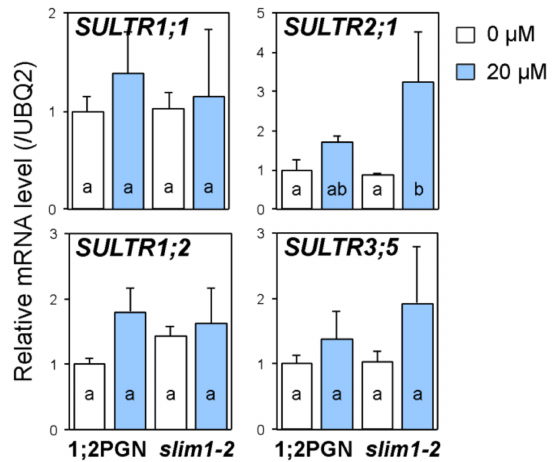
Figure 3. E ff ects of Cd treatment on transcript levels of SULTR s in 1;2PGN and slim1-2 roots. 1;2PGN and slim1–2 were grown for 10 days on MGRL agar medium containing 0 (white bars) or 20 (light blue bars) µ M CdCl 2 . Transcript levels of SULTR s in roots were determined by quantitative real-time PCR (qRT-PCR). The average values are indicated with error bars denoting SEM ( n = 3–4). Di ff erent letters indicate significant di ff erences among experimental groups (Tukey-Kramer test; p < 0.05).